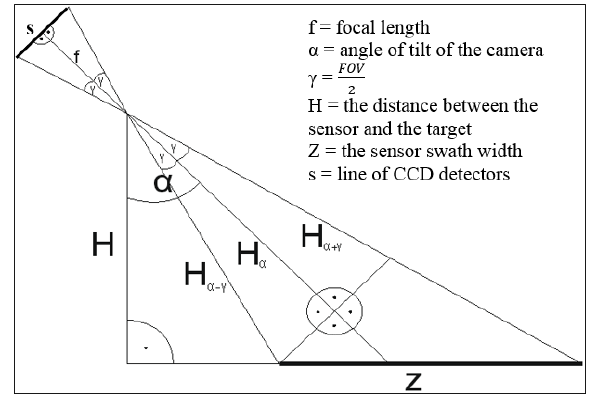
Figure 5. The diagram of image acquisition with electro- optic